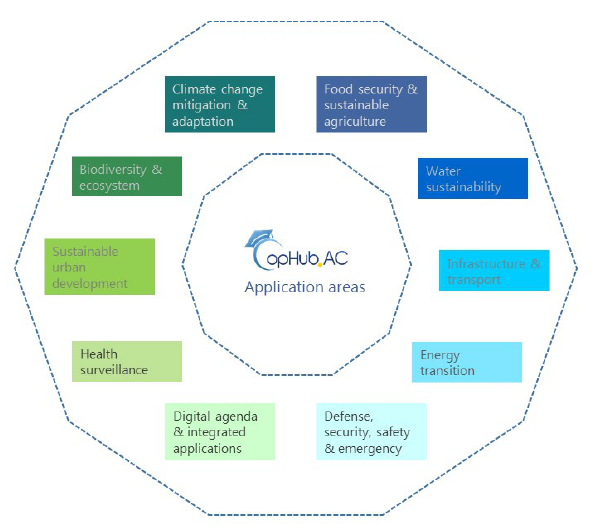
Figure 3. Gateway - application areas